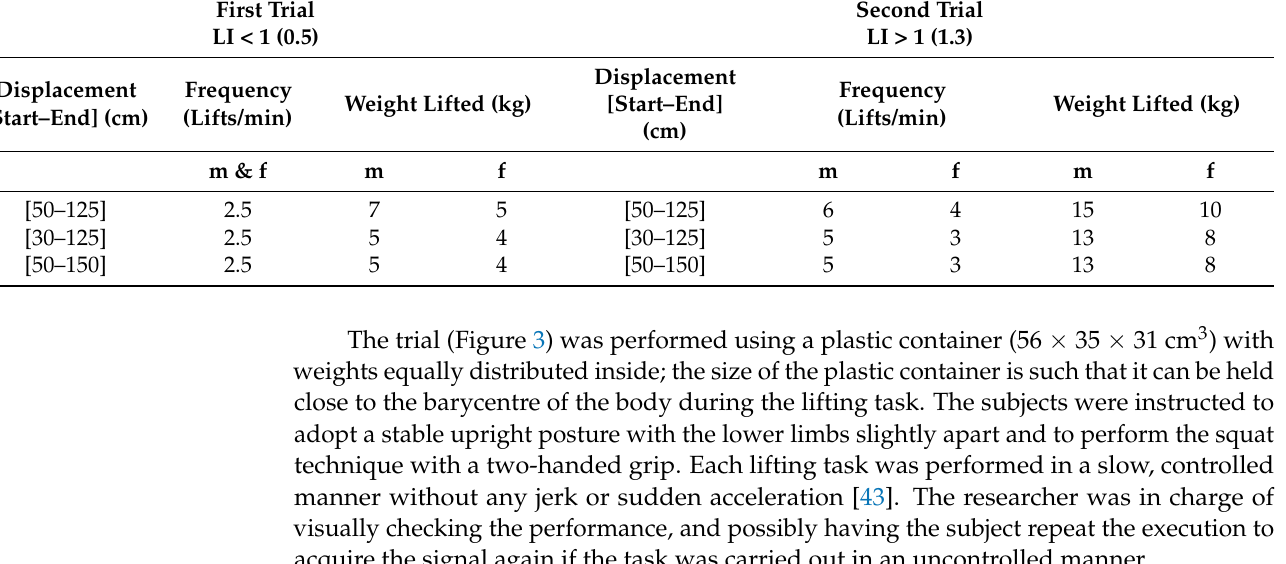
Table 2. Combinations of the height, frequency and weight variables for lifting activities corresponding to LI 0.5 and 1.3. First Trial LI < 1